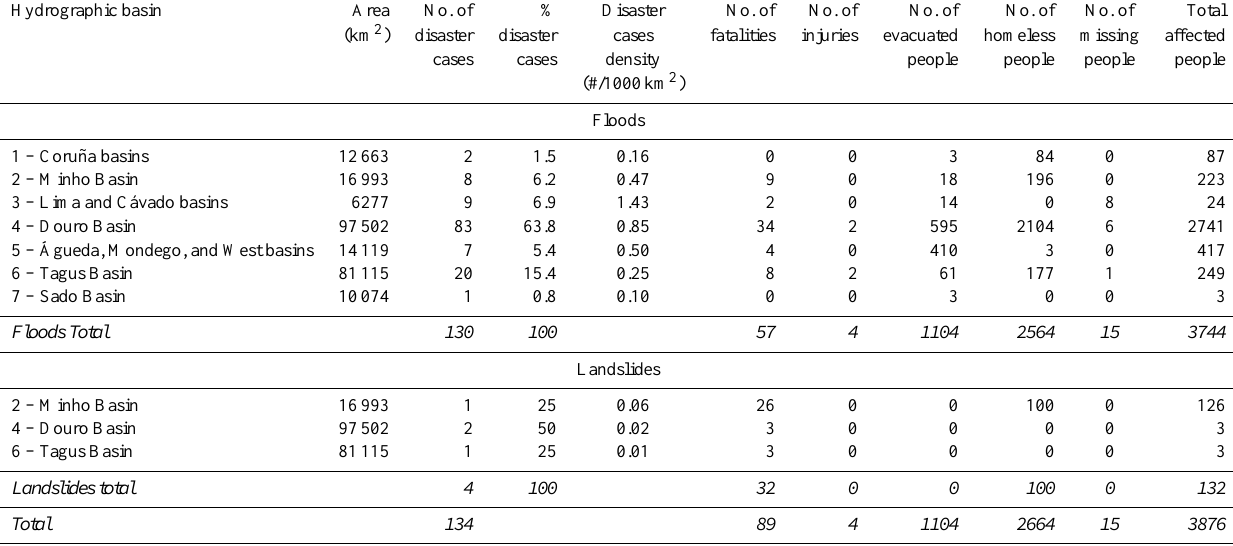
Table 3. Social consequences of the December 1909 event per hydrographic basin. Hydrographic basin